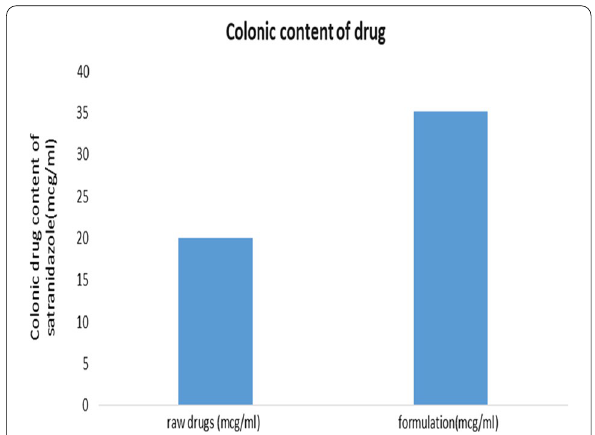
Fig. 6 Histogram diagram of mean concentration of colonic free administered drug and test formulation